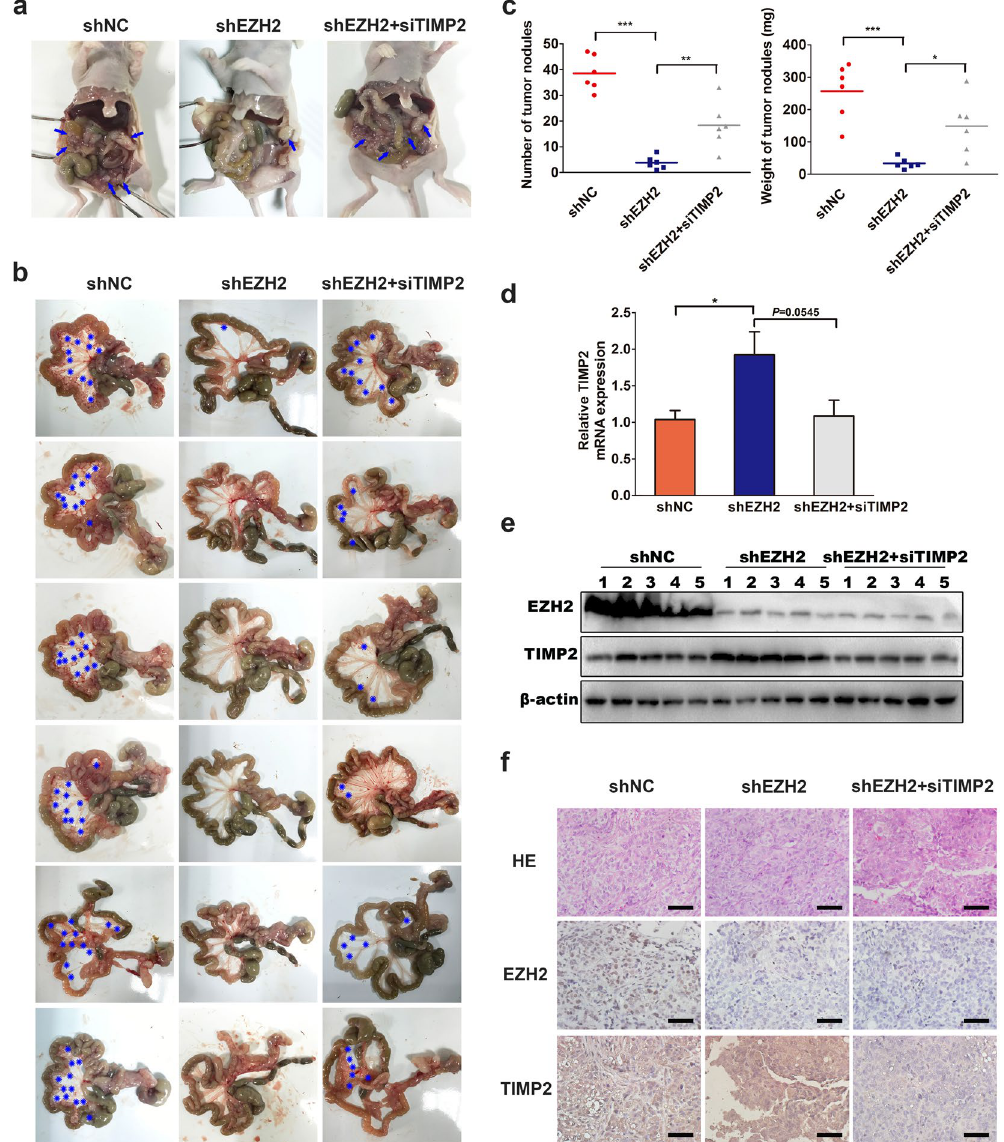
Figure 4. Down-regulation of EZH2 inhibits ovarian cancer metastasis by elevating TIMP2 in xenograft models. Nude mice were intraperitoneally inoculated with SKOV3 cells stably transfected with shNC or shEZH2. In vitro transient transfection and in vivo transfection of siTIMP2 was performed in one subgroup inoculated with SKOV3-shEZH2. ( a ) Peritoneal dissemination of xenografts. SKOV3-shEZH2 cells formed many fewer i.p. metastatic nodules (blue arrow) in the abdominal cavity of mice than SKOV3-shNC cells. In contrast, the transfection of siTIMP2 could significantly increase the reduced tumor metastatic nodules mediated by EZH2 depletion. ( b ) Representative images of the mesenteric membrane of six mice per group are shown. * Indicates tumor nodule. ( c ) The histogram of quantified weight of metastatic nodules > 8 mm 3 and the number of metastatic nodules in three groups at the time of sacrifice are shown. ( d ) RT-PCR results of TIMP2 mRNA expression of the eighteen SKOV3 xenografts in three groups. ( e ) Western blot analysis of EZH2 and TIMP2 protein expression of the xenografts. Five tissues for each group are shown because one tissue in the shEZH2 group and one in the cotransfected group were too small for protein extraction. The cropped blots are used in the figure, and full-length blots are presented in Supplementary Fig. S9. ( f ) The hematoxylin and eosin staining and immunohistochemical analysis of xenografts. EZH2 and TIMP2 protein expressions in control and intervention groups were verified. (scale bar, 20 μ m). * P < 0.05; ** P < 0.01; *** P <